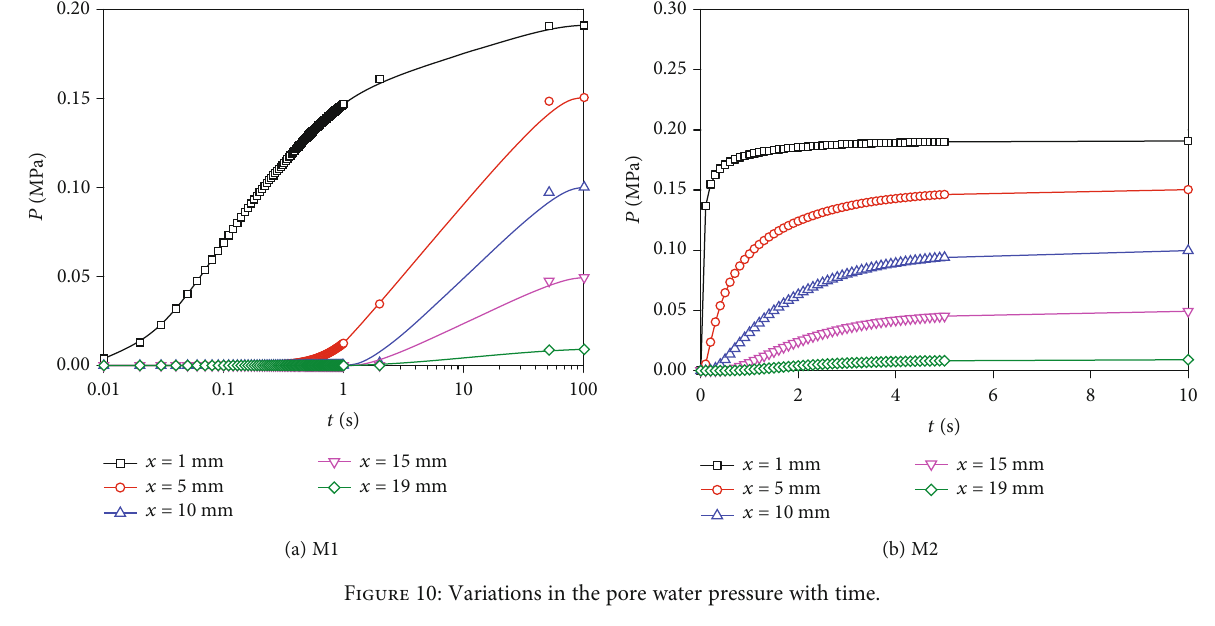
Figure 10: Variations in the pore water pressure with time.